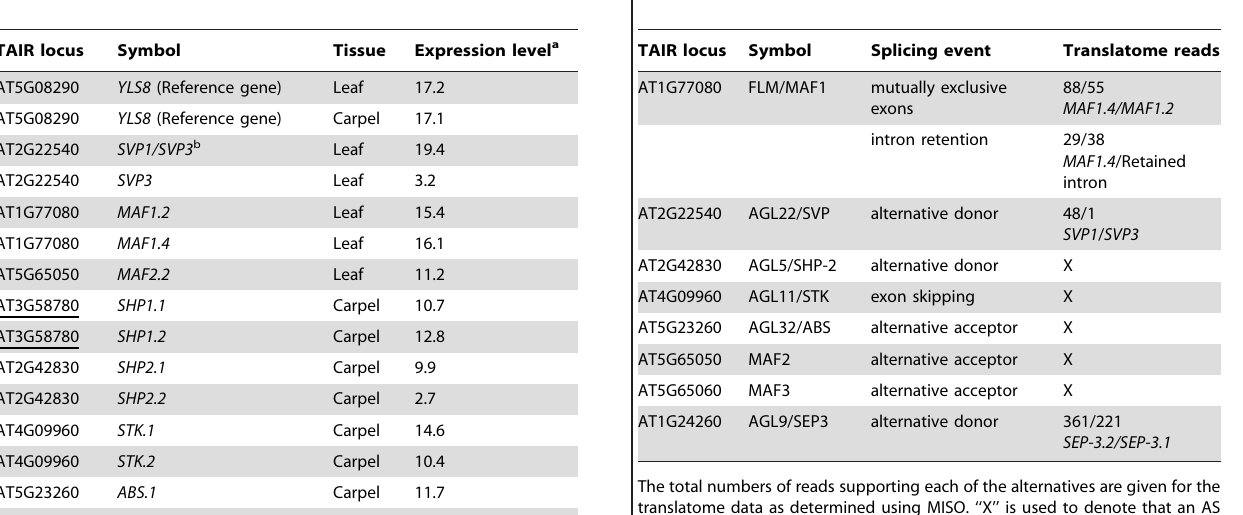
Table 2. Additional expression evidence for the predicted functional AS event.